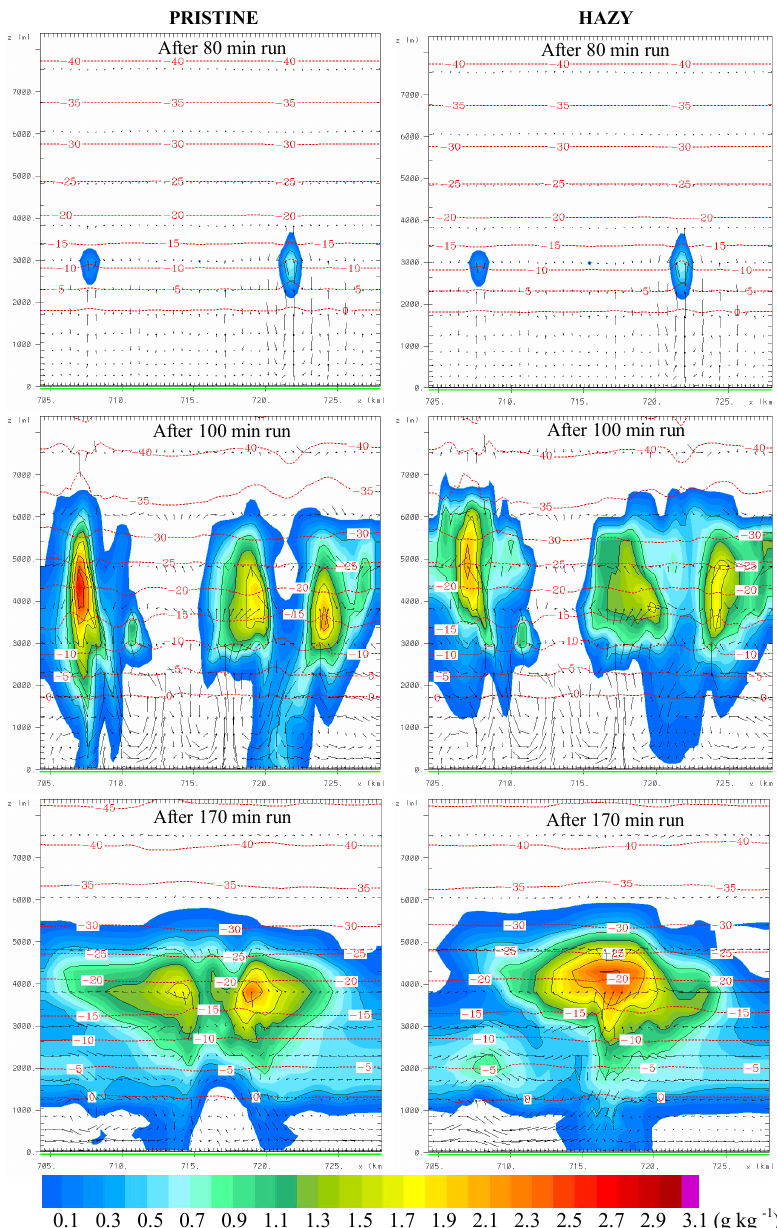
Fig. 3. Total condensates mixing ratio (gkg − 1 ) for the “pristine” (left column) and the “hazy” (right column) scenarios.